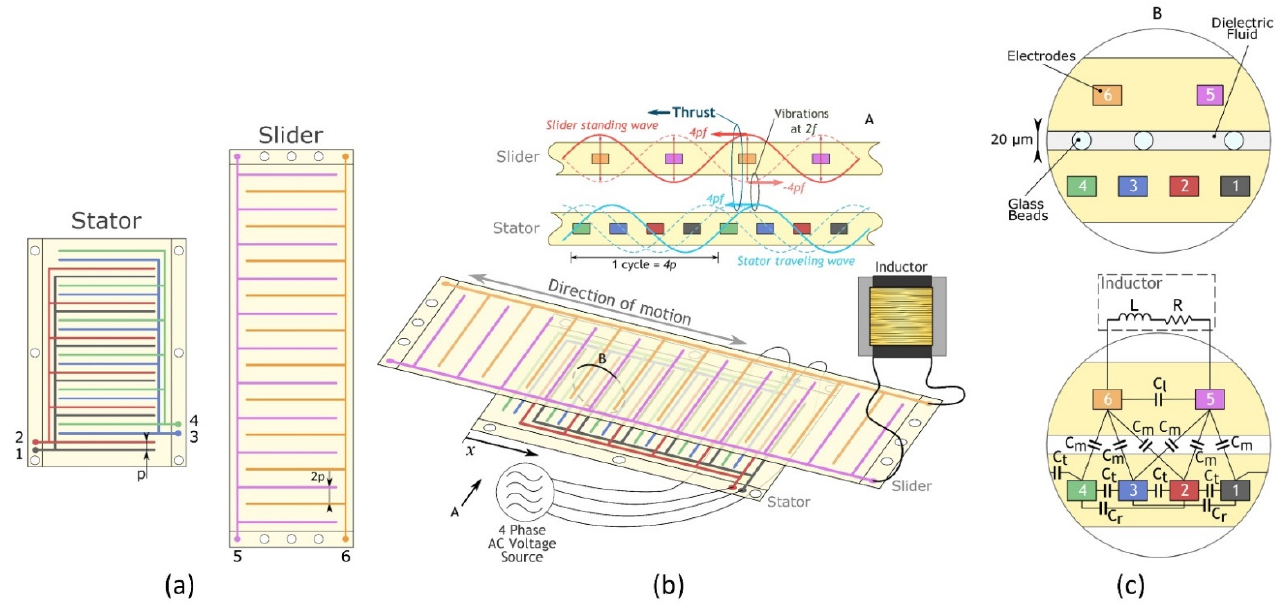
Figure 15. Schematic images of the 2–4-phase resonant electrostatic induction motor: ( a ) the general layout of the films, p—pitch for the stator electrode, 2p—pitch for the slider electrode; ( b ) their typical arrangement, external circuit components, and working principle; and ( c ) a more detailed section view with identification of the discrete capacitive elements. Adapted from [105].